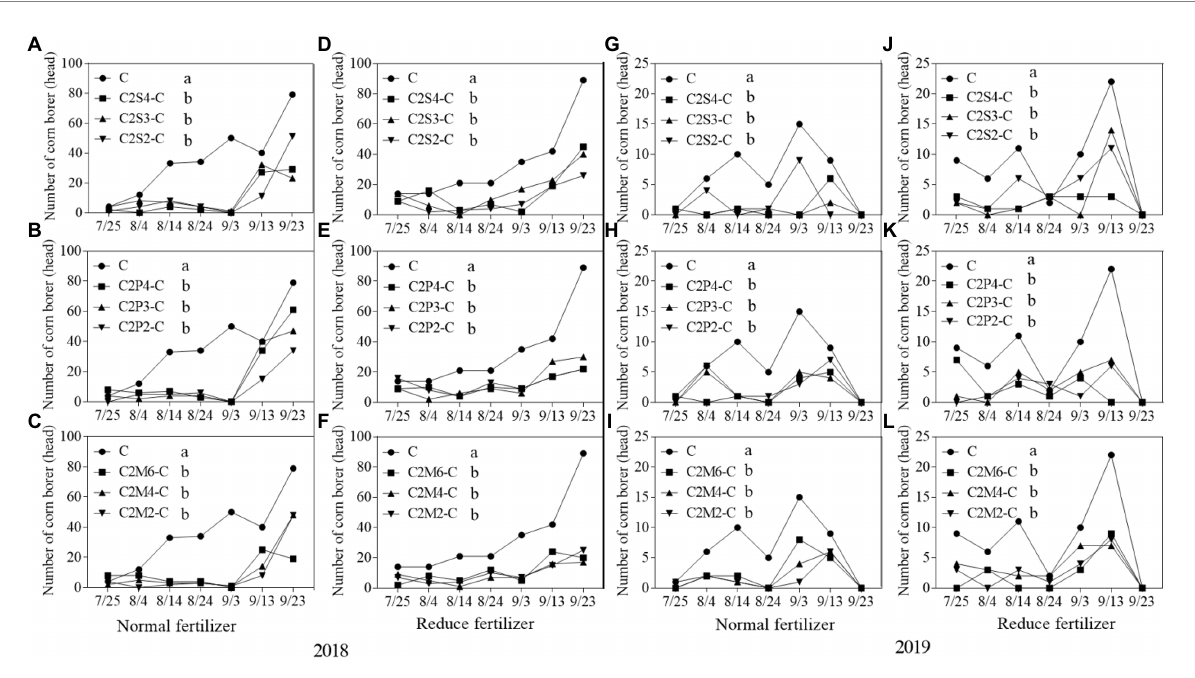
FIGURE 5 Population dynamics of key herbivorous insect, Asian corn borers, that fed on per 30 corn plants intercropping with soybean, peanut, and millet under different planting patterns at normal and reduced fertilizer per 30 corn plants. A-C represent corn-soybean intercropping, corn-peanut intercropping and corn-millet intercropping under normal fertilizer in 2018, respectively. D-F represent corn- soybean intercropping, corn-peanut intercropping and corn-millet intercropping under fertilizer reduction in 2018, respectively. G-I represents corn-soybean intercropping, corn-peanut intercropping and corn-millet intercropping under normal fertilizer in 2019, respectively. J-L represent corn-soybean intercropping, corn- peanut intercropping and corn-millet intercropping under fertilizer reduction in 2019, respectively. C2S2-C, C2S3-C, C2S4-C: corn plants in the planting patterns of 2 corn rows intercropping with 2, 3, 4 rows of soybean; C2P2-C, C2P3-C, C2P4-C: corn plants in the planting patterns of 2 corn rows intercropping with 2, 3, 4 rows of peanut; C2M2-C, C2M4-C, C2M6-C: corn plants in the planting patterns of 2 corn rows intercropping with 2, 4, 6 rows of millet. Different lowercase represents a significantly different average of the 7 evaluations among different planting patterns at the same fertilizer level and the same intercropping type by the LSD test at p < 0.05,